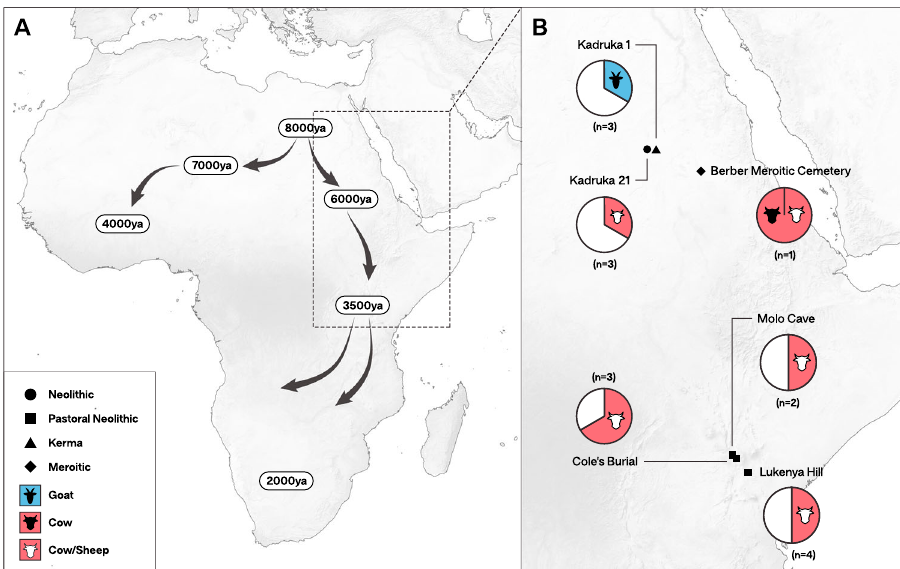
Fig. 2 Map of sites with calculus containing milk proteins. A Area of study in relation to the spread of cattle-based pastoralism across Africa (after Marshall and Hildebrand 35 ). B Pie charts showing the number of individuals per site with milk proteins (shaded) proportionate to the total number of individuals that passed screening with Oral Signature Screening Database (see “ Methods ” and Supplementary Note 3 for full details). Neolithic: ~8000 – 5500 cal. BP ; Kerma: ~4450 – 3450 cal. BP ; Pastoral Neolithic: ~3500 – 1200 cal. BP ; Meroitic: ~2300 – 1600 cal. BP . The maps were created for this study by Michelle O ’ Reilly (Graphic Designer for the Max Planck Institute for the Science of Human History, Jena, Germany) using QGIS 3.12 [https://qgis.org/ en/site/] and the Natural Earth Database from [https://www.naturalearthdata.com/downloads/]. Additional edits were made using Adobe Illustrator